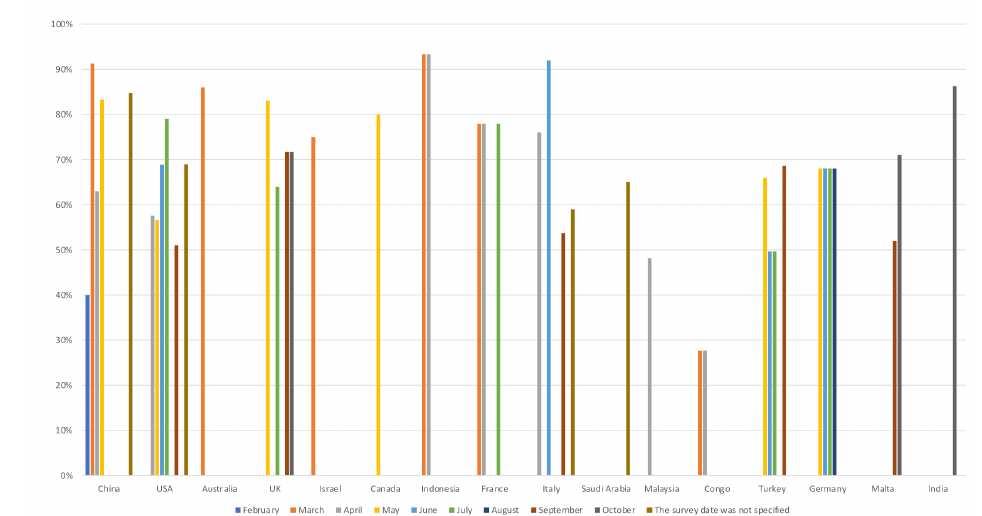
Figure 2. The prevalence of intention to receive COVID-19 vaccines